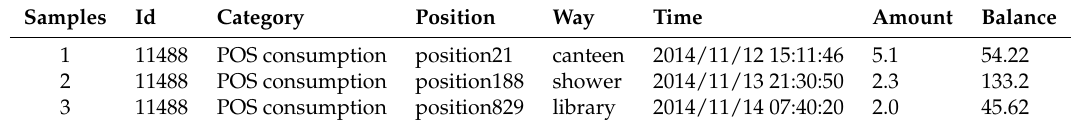
Table 3. Samples of the card data.